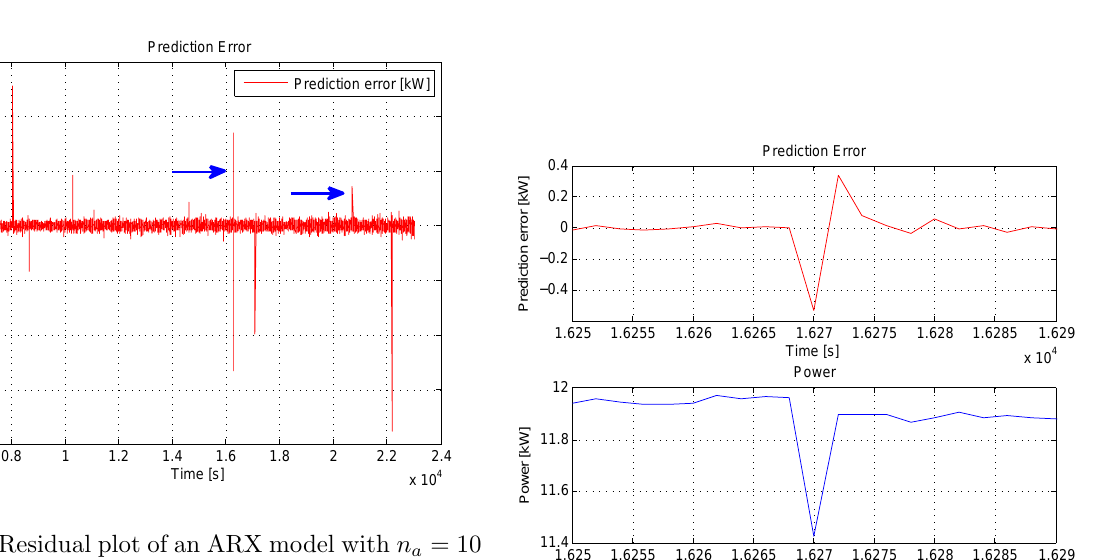
Figure 3: Residual plot of an ARX model with n a = 10 and n b = 10.